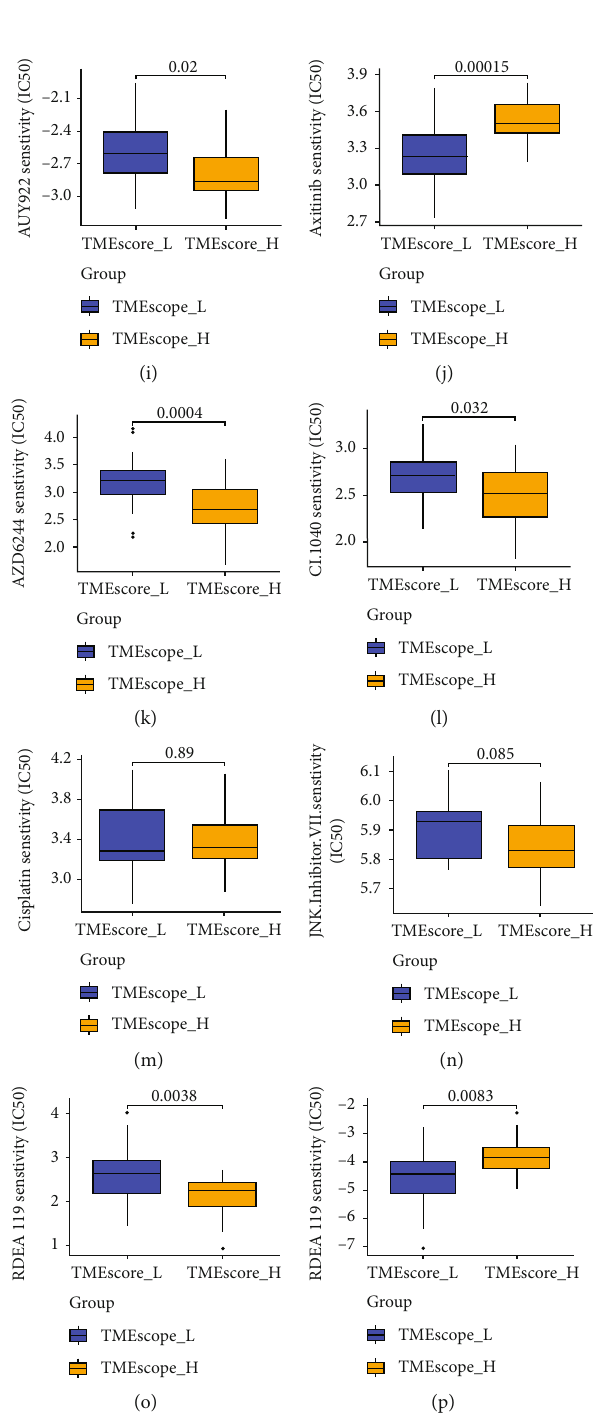
Figure 8: TMEscore is a prognostic biomarker and can predict the e ff ect of chemotherapy drugs. (a – h) Results of drug sensitivity analysis in TCGA cohort. (i – p) Results of drug sensitivity analysis in the GEO